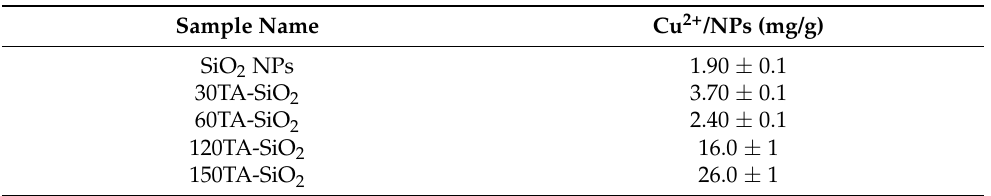
Table 4. Adsorption amount of copper detected by ICP-MS with an initial concentration of Cu 2+ equal to 20 mg/L (data collected at pH 7).